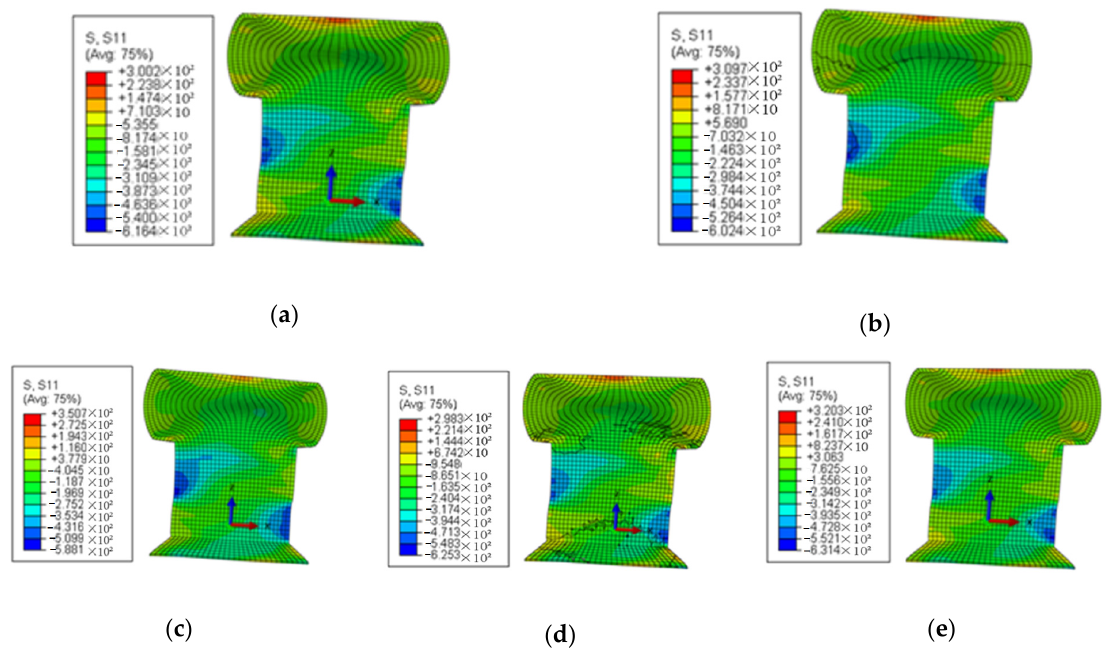
Figure 23. Stress distribution diagram of rivet under shearing force (unit: MPa): ( a ) stress distribution of rivet of 0° standard part (0-0); ( b ) stress distribution of rivet of joints of 1° in the 0° direction (0-1); ( c ) stress distribution of rivet of joints of 2° in the 0° direction (0-2); ( d ) stress distribution of rivet of joints of 1° in the 180° direction (180-1); ( e ) stress distribution of rivet of joints of 2° in the 180° direction (180-2).